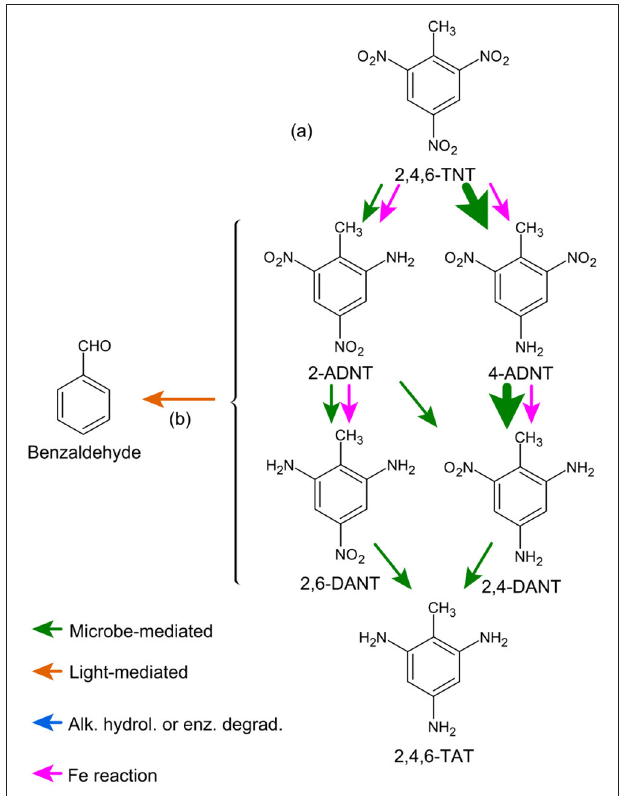
FIGURE 6 | TNT transformation via reduction of nitro groups. Arrow color indicates mechanism, and wider arrows indicate preferential pathways. Letters next to arrows correspond to literature references: a, Juhasz and Naidu (2007), Monteil-Rivera et al. (2009), Spanggord et al. (1983), Lenke et al. (2000), Spain (1995), Preuss et al. (1993), Hawari et al. (2000b), and Jarand et al. (2011); b, Schmidt and Butte (1999).